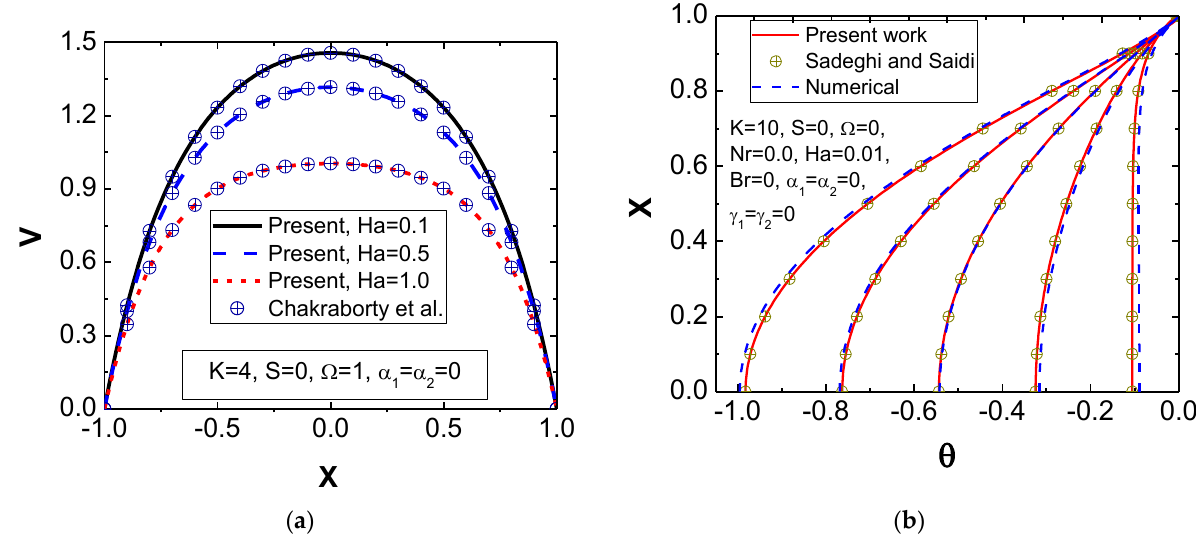
Figure 6. Validation of the present analysis for velocity and temperature distributions in microchan- nels. ( a ) Velocity distribution determined by present analysis and published work [393]; ( b ) Tem- perature distribution determined by present analytical and numerical analyses and published work [76].